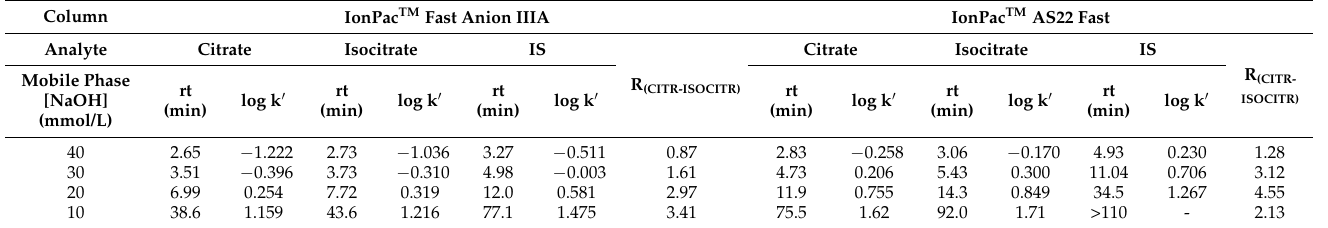
Table 1. Method development preliminary proofs. Measured rt and log k (cid:48) for citrate, isocitrate, and IS peaks, and R (citr-isocitr) as a function of mobile phase